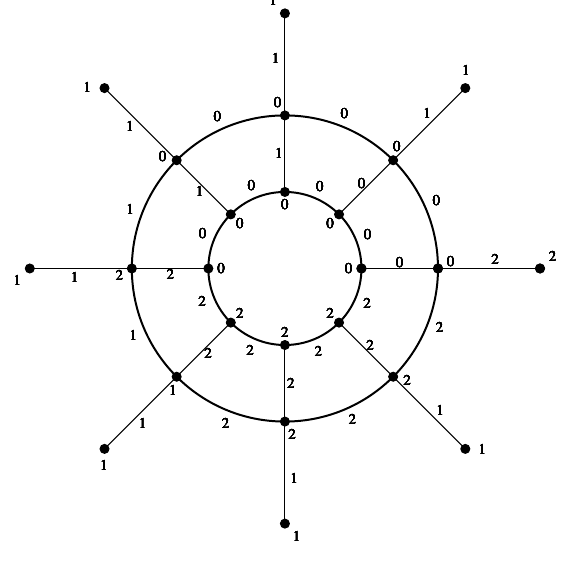
Fig. 7 3-TEPC labeling of W